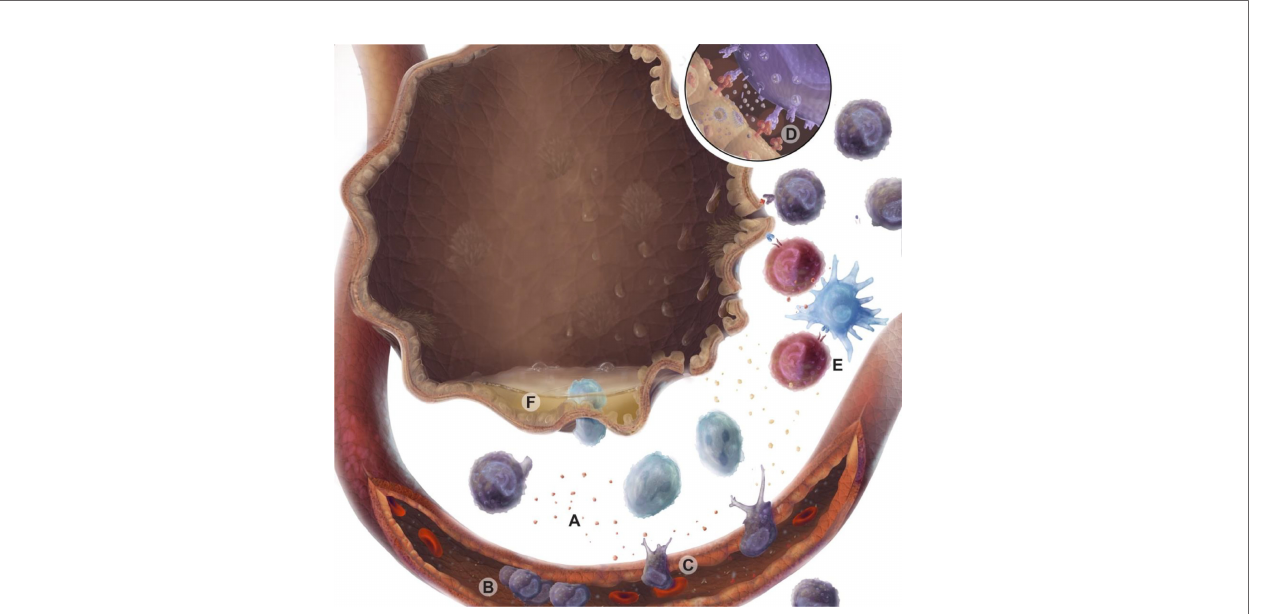
FIGURE 1 | Immune cell responses during ischemia reperfusion injury (IRI). Warm ischemia, cold ischemia, and subsequent reperfusion with oxygenated blood lead to oxidative and mitochondrial cell stress, which are associated with epithelial injury. These injured epithelial cells produce damage molecular patterns (DAMPs) and chemokines (A) that recruit and activate immune cells via the vascular endothelium. Activated endothelium tether passing leukocytes from the circulation via selectins and integrins, causing immune cells to roll and adhere (B) prior to transmigration across a chemotactic gradient (C) . Lymphocyte activation is driven through MHC binding to T cell receptors or NK cell receptor ligand interactions. These activated lymphocytes may secrete cytotoxic perforin and granzyme molecules (D) . Professional antigen presenting cells can also present alloantigen to T cells amplifying graft-speci fi c responses in response to injury (E) . Epithelial cell loss of tight junctions and breakdown results in barrier dysfunction and interstitial edema (F)